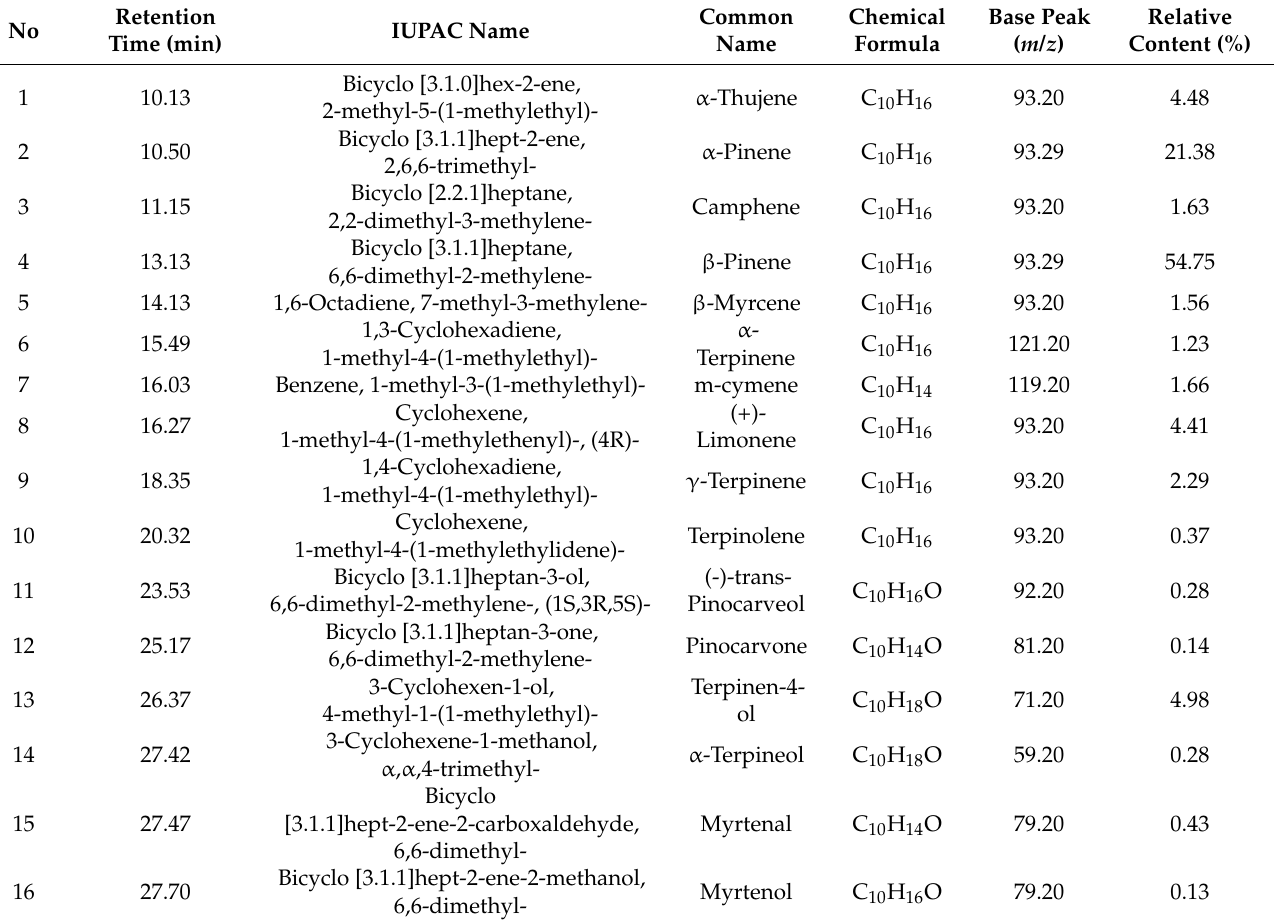
Table 11. The volatile oil of mixtures of F. suspensa and L. japonica